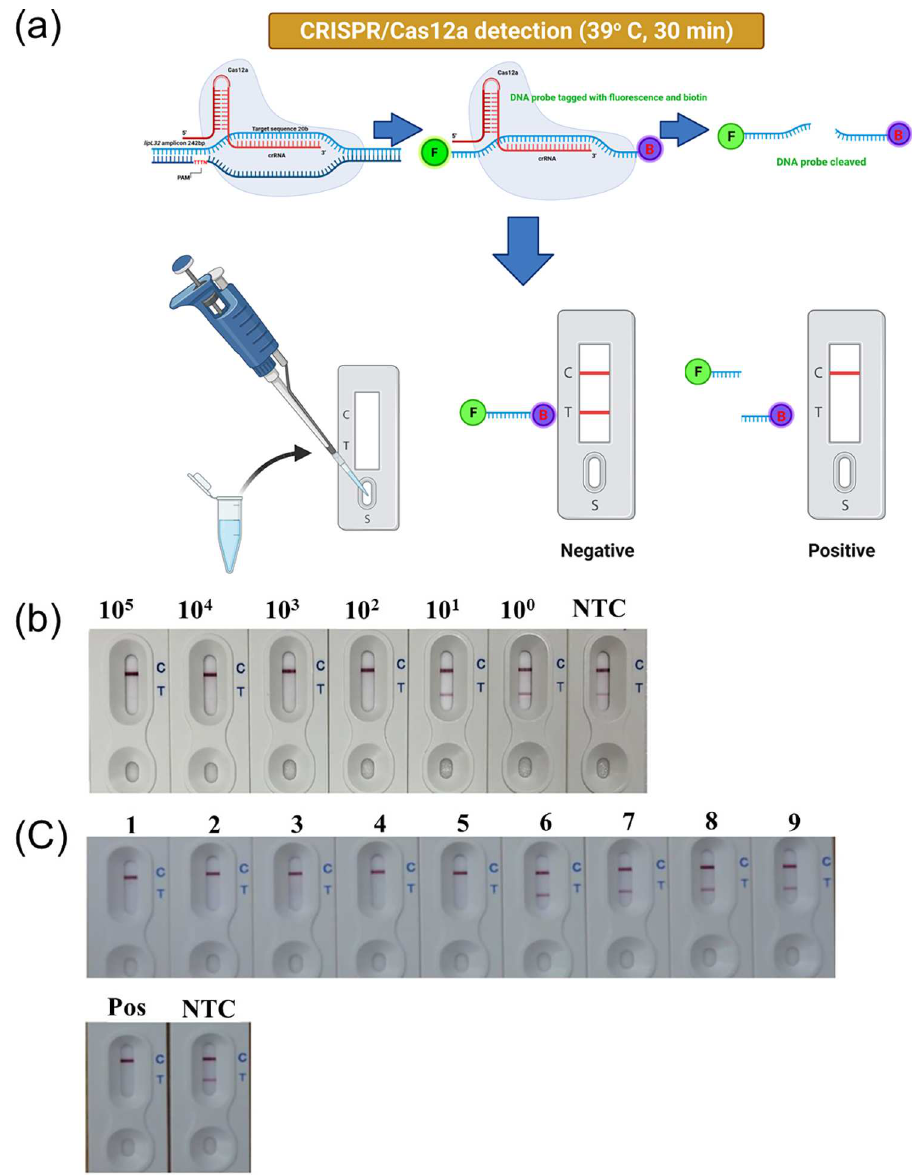
Fig 3. The RPA-CRISPR/Cas12a-LFDA. (A) The RPA-CRISPR/Cas12a-LFDA’s workflow (Created with BioRender. com), (B) LOD, and (C) clinical sample validation [1–5 and 6–9 are known positive and negative samples, respectively, while NTC and Pos are the no-template negative and positive control,